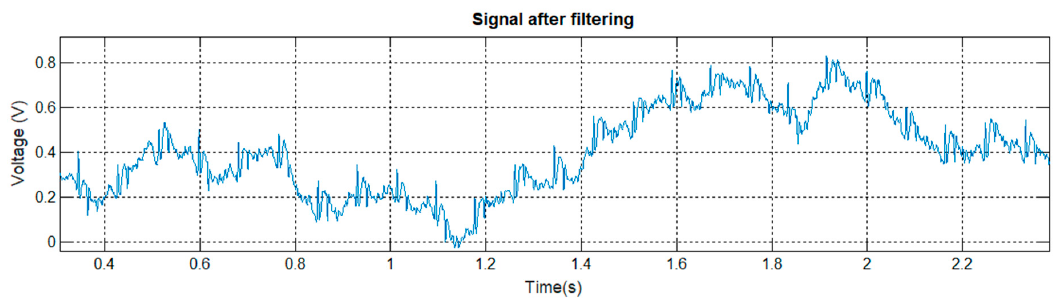
Figure 9. Physiological signal obtained while the mouse placed two paws on two different EPIC sensors of the matrix (after filtering).